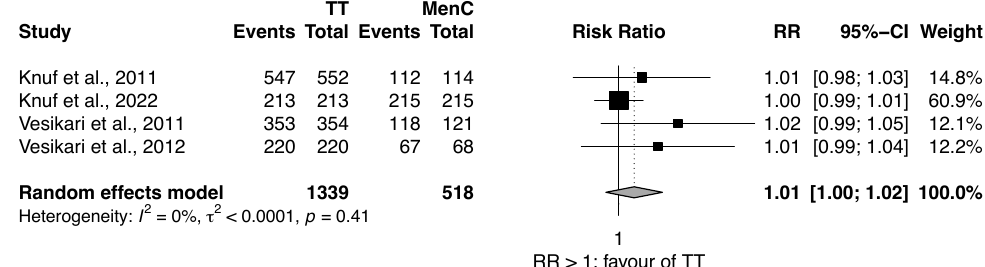
Figure A3. Efficacy of MenACWY-TT vs. MenC (Serogroup C). Subgroup analysis for 12–23 months age group